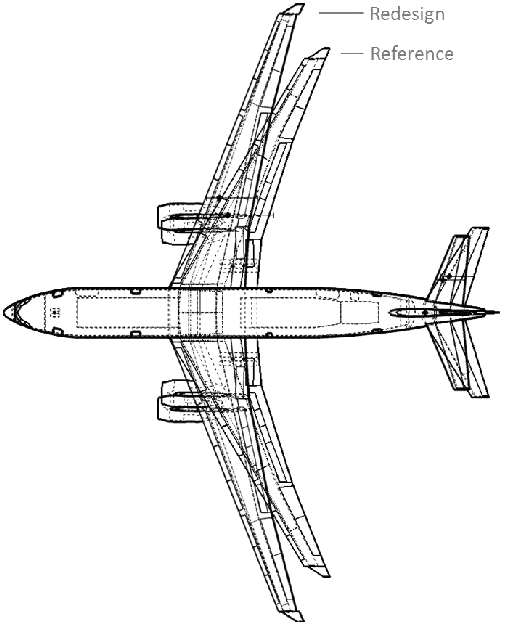
Figure 12. Geometrical dimensions of the reference and redesigned aircraft [48].